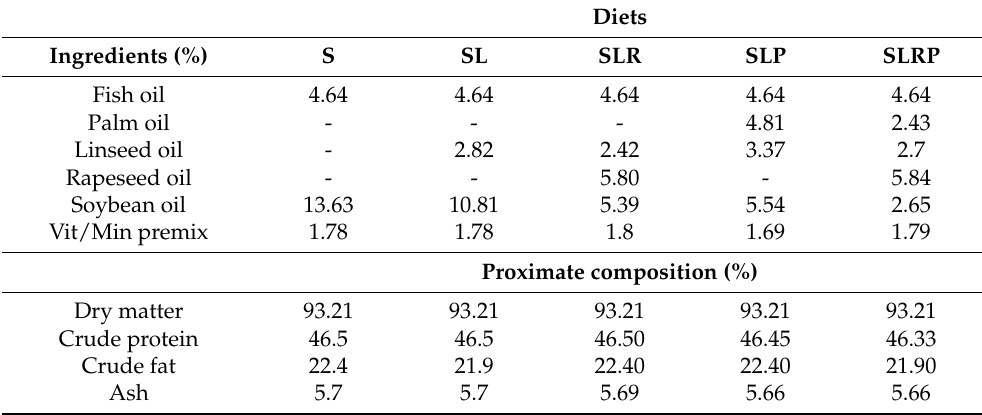
Table 1. Oil composition and Vitamin/Mineral (Vit/Min) premix and proximate composition of the experimental